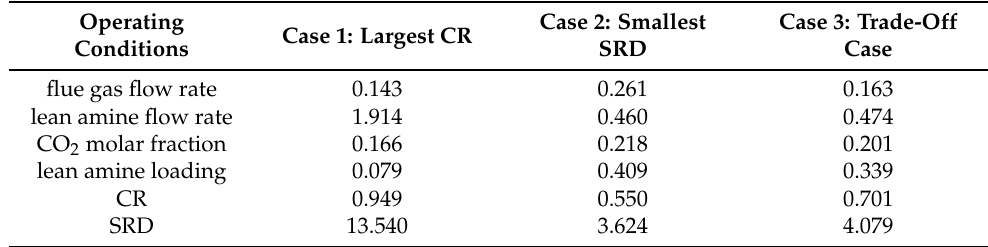
Table 7. Optimized operating conditions for SA algorithm implementation. Case 1: Find the operating conditions that resulted in the largest CR without leveraging the value of SRD. Case 2: Find the operating conditions corresponding to the smallest SRD without leveraging the value of CR. Case 3: A trade-off case, aims to find a relatively high CR and low